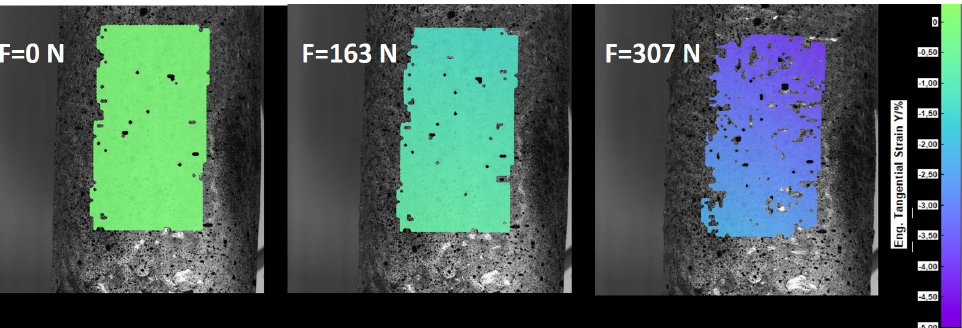
Figure 2. The strain distribution recorded by the DIC system for PP and vacuum pressure at 0.07 MPa. To evaluate changes in granule morphology during cyclic loading, specimens were taken from samples subjected to cycling loading after 200 and 2000 cycles. Granules in as-received condition were also characterized as a reference material. Granules were evaluated by light microscopy as well as by SEM, which was conducted on a Hitachi Su-70 microscope. Granules were also subjected to microhardness testing in a Vickers scale and a load of 10 g, marked as